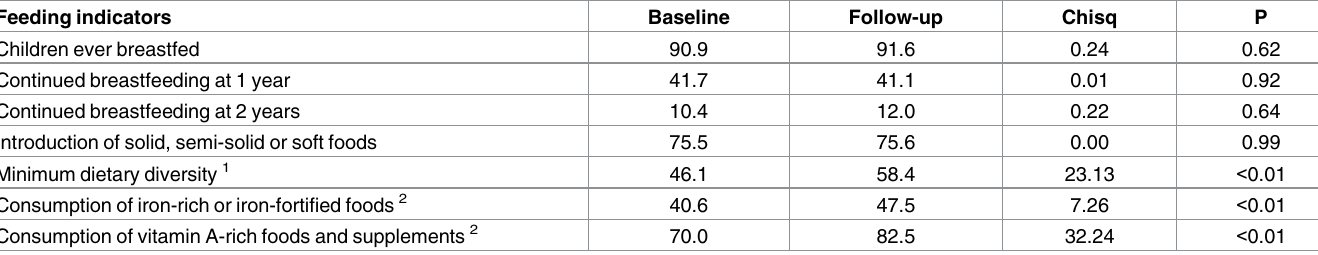
Table 2. Feeding practicesof children in the baseline and follow-up surveys(%). Feeding